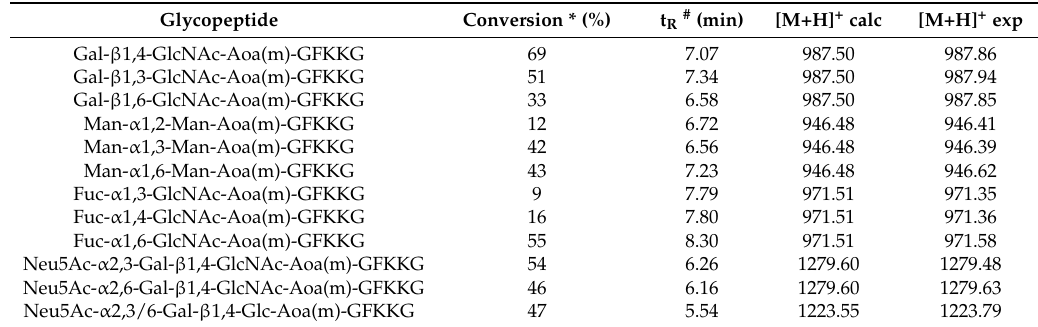
Table 5. Synthetic neo-glycoprobes displaying different